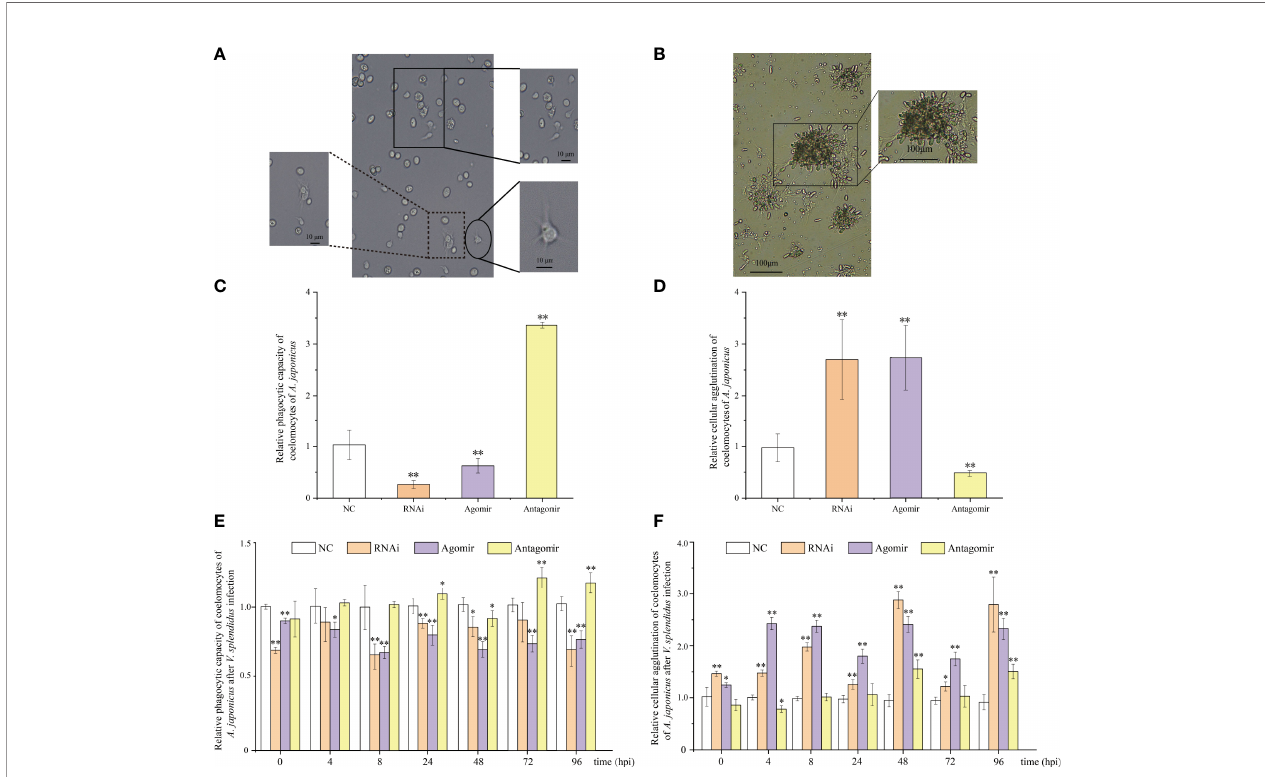
FIGURE 4 | Functional analysis of miR-7 and AjPAK1 on phagocytic capacity and cellular agglutination of coelomocytes in Apostichopus japonicus. (A) Morphology of phagocytes and the process of phagocytosis of yeast cells of A. japonicus. The solid box indicates that phagocytes extend pseudopods and approach yeast cells; the dotted box represents phagocytes that engulfed yeast cells; the ellipse frame indicates the normal morphology of the phagocytes. (B) Cellular agglutination effect of coelomocytes in A. japonicus . (C) Effects of AjPAK1 silencing, miR-7 overexpression, and miR-7 inhibition on relative phagocytic capacity of coelomocytes of A. japonicus . (D) Effects of AjPAK1 silencing, miR-7 overexpression, and miR-7 inhibition on relative cellular agglutination of coelomocytes of A. japonicus . (E) Effects of AjPAK1 silencing, miR-7 overexpression, and miR-7 inhibition on relative phagocytic capacity of coelomocytes of A. japonicus after Vibrio splendidus infection. (F) Effects of AjPAK1 silencing, miR-7 overexpression, and miR-7 inhibition on relative cellular agglutination of coelomocytes of A. japonicus after V. splendidus infection. NC, negative control; RNAi, AjPAK1 silencing; Agomir, miR-7 overexpressed; Antagomir, miR-7 inhibition ** represents an extremely signi fi cant difference compared with NC ( P < 0.01); * represents signi fi cant difference compared with NC ( P <